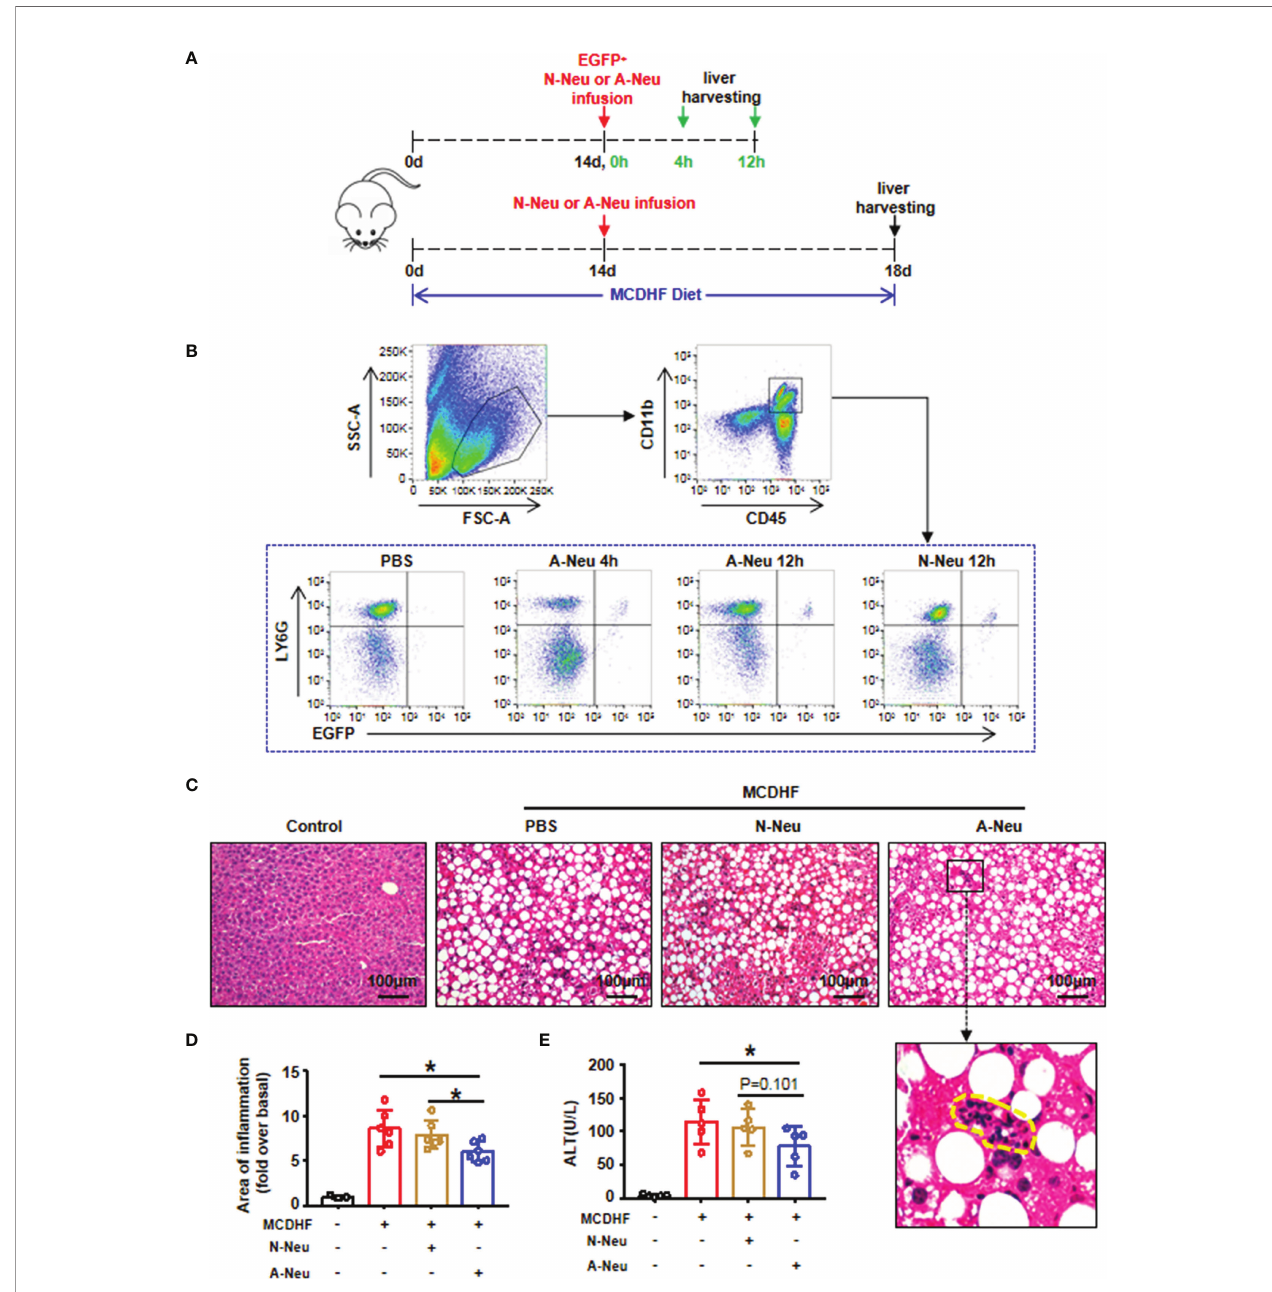
FIGURE 1 | Infusion of A-Neu ameliorated MCDHF-induced liver injury in mice. (A) Schematic diagram of experimental design of tail vein injection of neutrophils (5×10 6 cells/mouse) after 2 weeks of MCDHF diet in mice. (B) Representative fl ow cytometry analysis of EGFP + Ly6G + neutrophils on CD45 + CD11b + monocytes in the liver ofmice in4 hours or 12 hoursafter injection ofEGFP + N-Neu or EGFP + A-Neu. (C) Infusing N-Neu or A-Neu into mice after 2 weeksof MCDHF diet andharvesting liver in 4 daysafter injection. The representative H&Estaining images of liver sectionswere performed,in fl ammatory area was indicated by circle. (D) Areas of In fl ammation were quanti fi ed,(control group, n=3; MCDHF group, n=6). (E) Serum ALTlevels were measured in indicated groups, n=5 each group. The results werepresented as mean ± SD.One-way ANOVA was used. *P < 0.05. Scale bar = 100 m m. MCDHF,methionine-choline-de fi cient and high-fat diet; A-Neu, activated neutrophil;